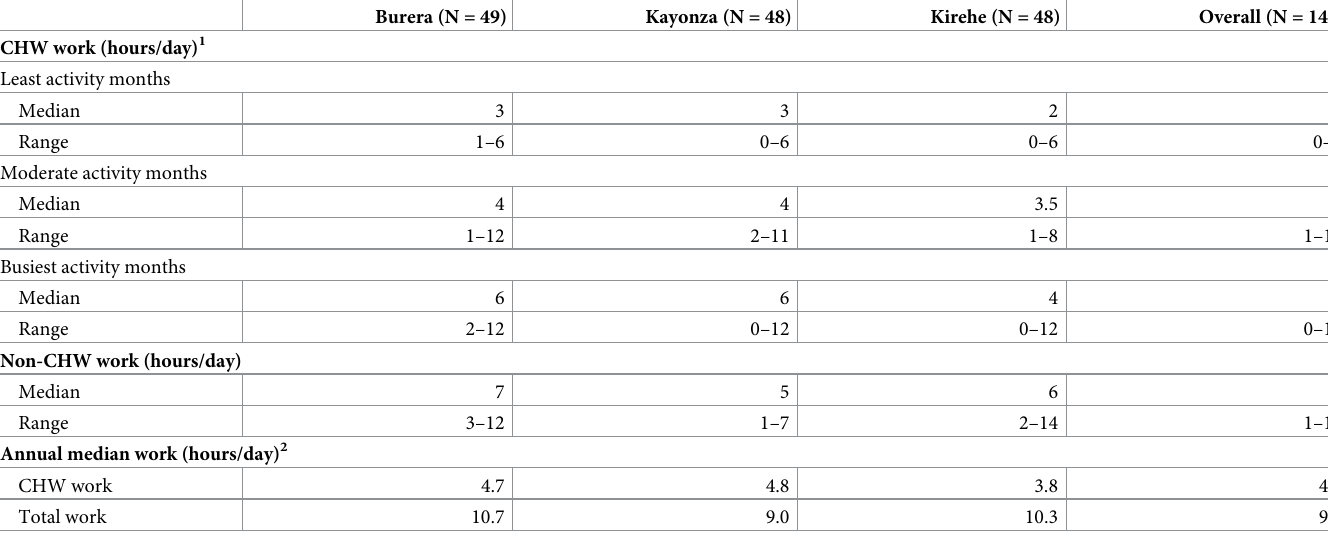
Table 3. Summary of time outputs reported by participants on Community Health Worker (CHW) activities per person per day in three districts of Rwanda.